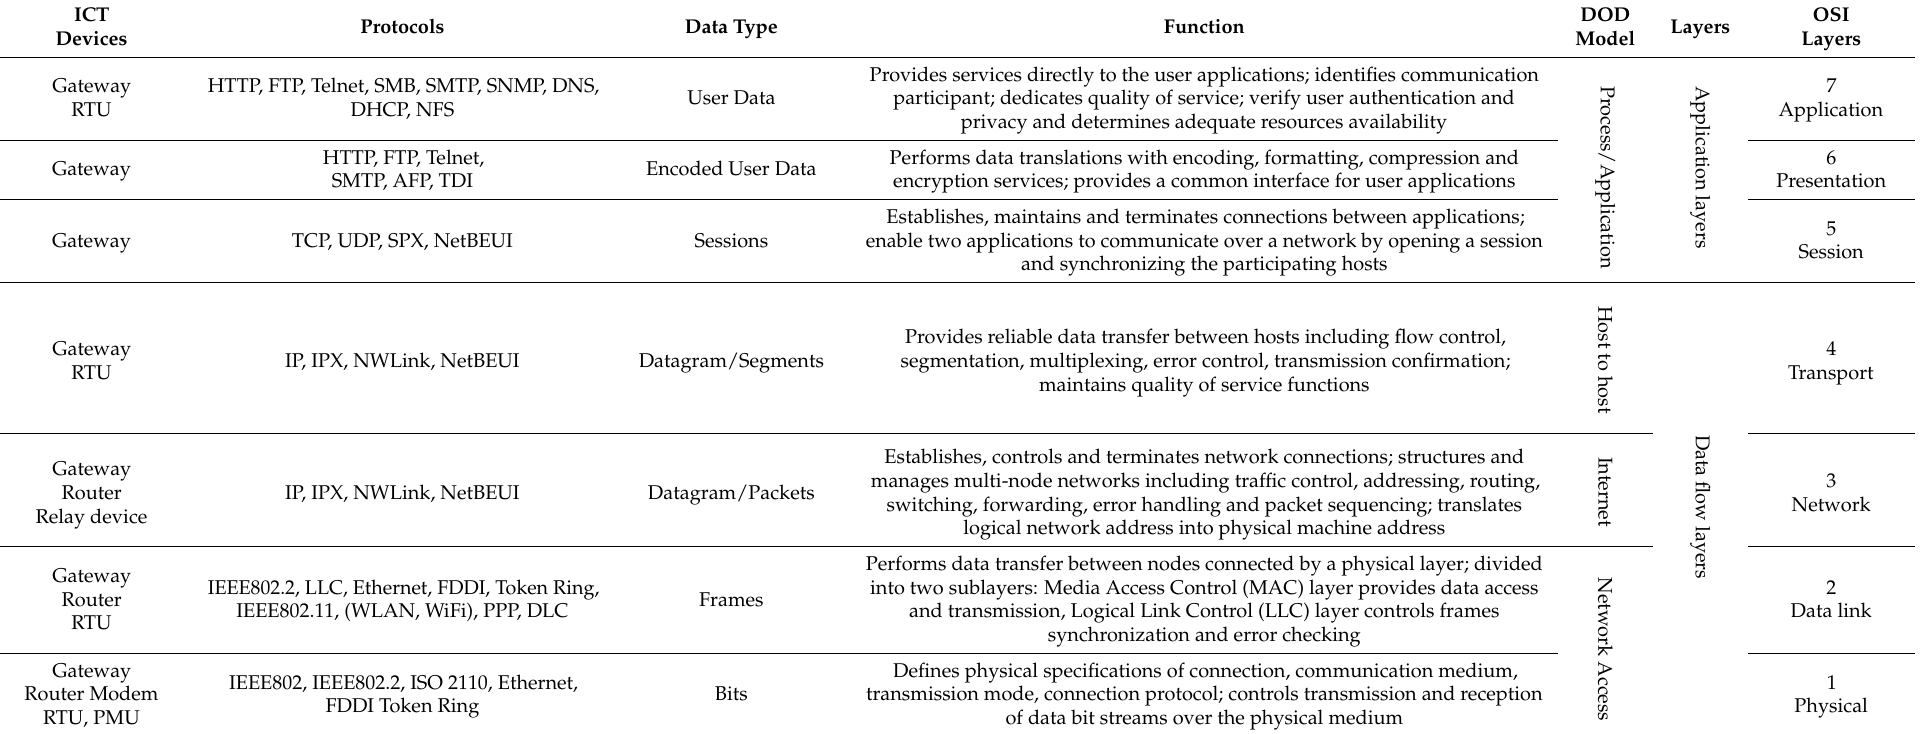
Table 7. Comparison of ICT equipment in OSI model